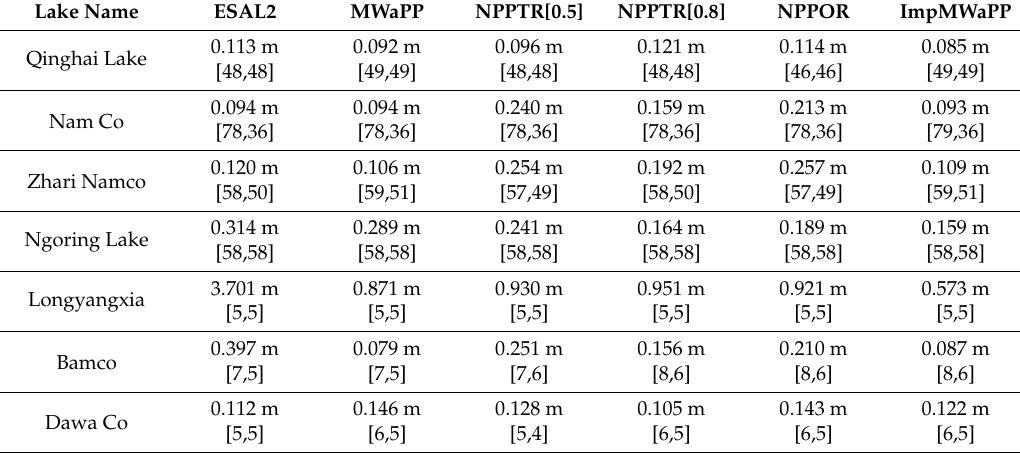
Table 2. Root-mean-squared errors (RMSEs) for the seven lakes between the Cryosat-2 time series and the in situ